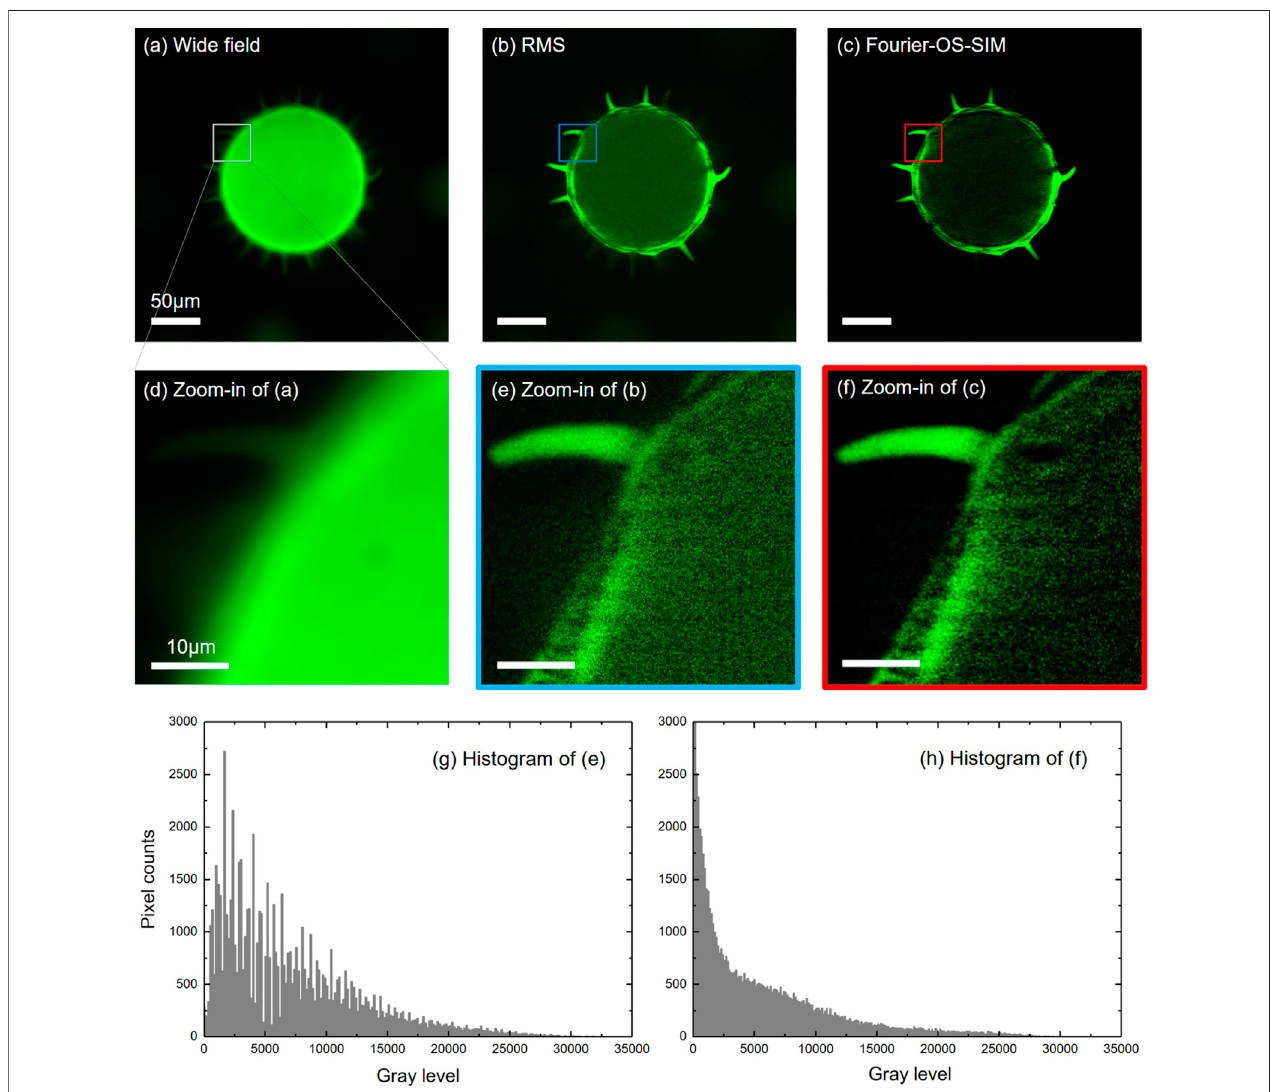
FIGURE2|E xperimentalresultsoftheFourier-OS-SIMincomparisonwiththeWide- fi eldandRMSalgorithmforimagingpollengrains. (A – C) :imagesoftheWide- fi eld, RMS, and Fourier-OS-SIM, respectively. (D – F) : the zoom-in parts of the marked areas indicated in (A – C) . (G – H) : the histograms of (E,F) , respectively.